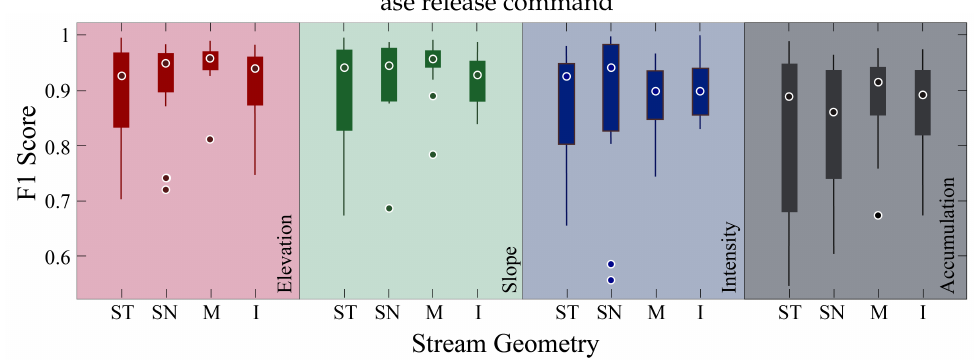
Figure 8. Boxplots of the F1 score across different stream geometries and feature classes. The different colors represents the different features: elevation (red), slope (green), intensity (blue), and flow accumulation (grey). The F1 score for elevation, slope, intensity, and flow accumulation ranged from 0.7–0.98, 0.67–0.98, 0.66–0.97, and 0.55–0.97. The stream types analyzed here are straight (ST), sinuous (SN), meandering (M), and braided or streams with junctions (I). The F1 score for straight, sinuous, meandering, and intersecting/multi-threaded ranged from 0.55–0.98, 0.60–0.97, 0.68–0.98, and